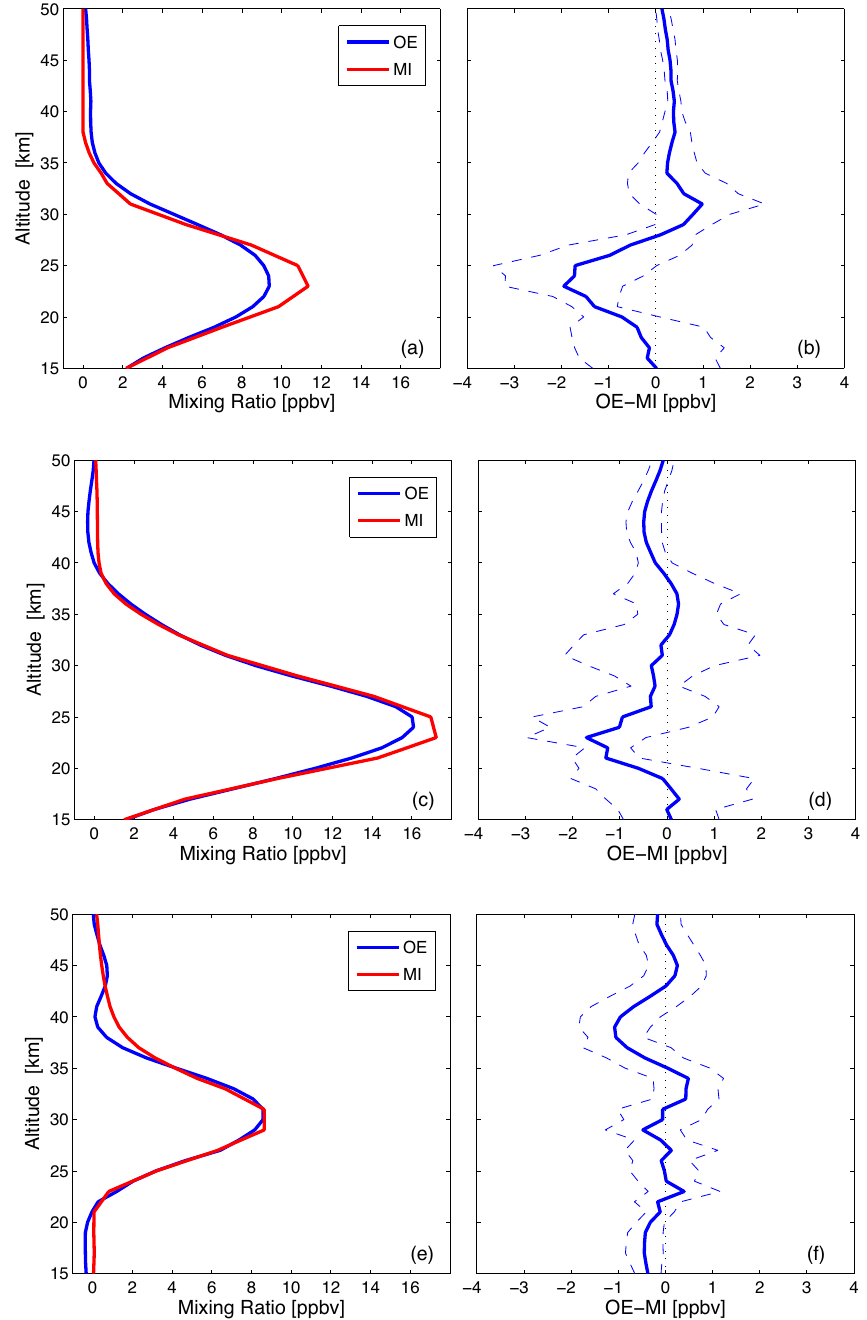
Fig. 6. Left panels: comparison between HNO 3 profiles retrieved with the constrained Matrix Inversion (red line) and the Optimal Estimation (blue line) techniques. Right panels: absolute differences between the profiles retrieved using the two different techniques. Dashes lines are standard deviations of these differences. The comparison is presented for three illustrative cases: 2005 winter at Testa Grigia (13 days) (panels a and b ), 1993–1995 fall at South pole (5 days) (panels c and d ), 1993–1995 winter at South Pole (16 days) (panels e and f ).